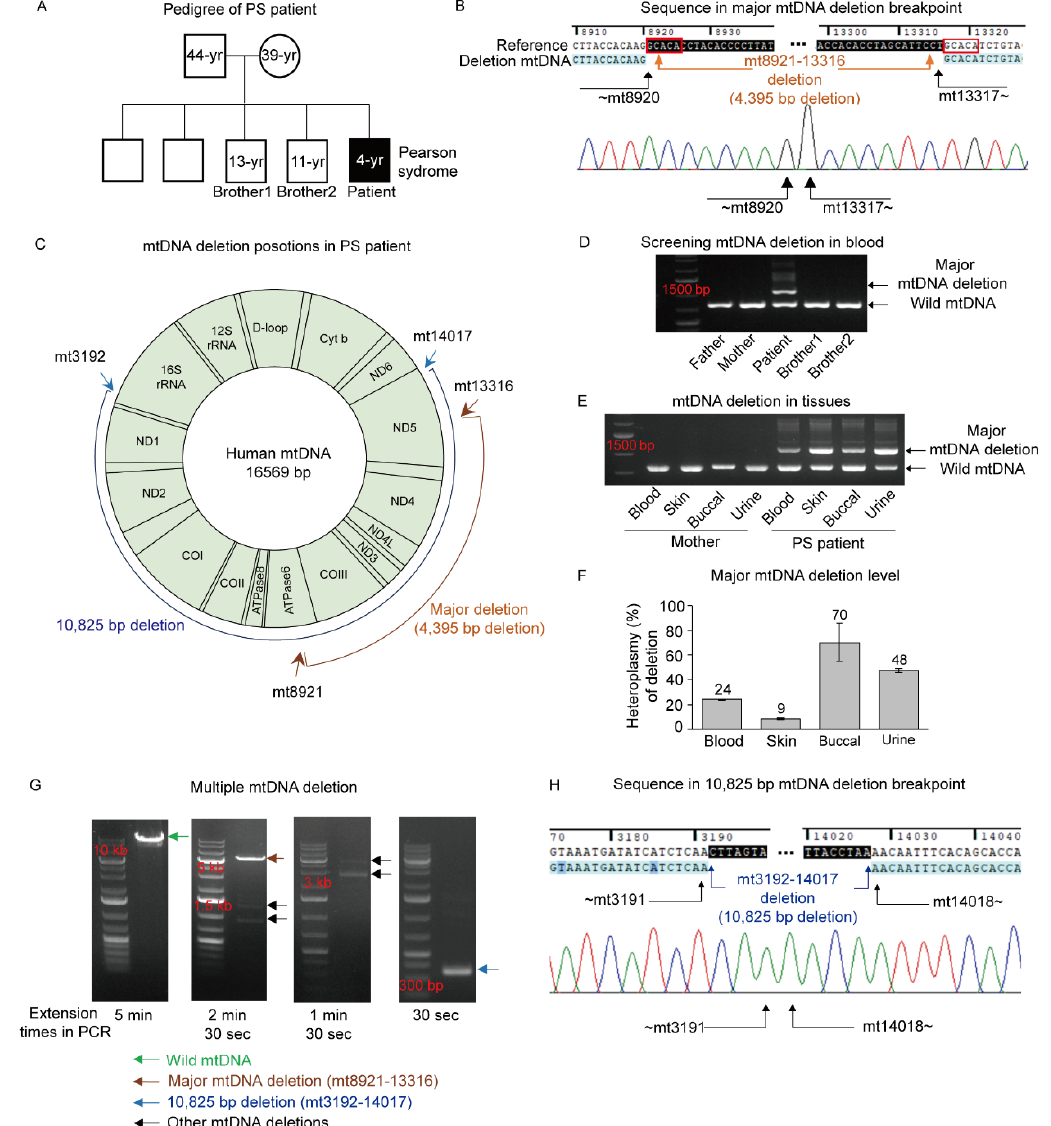
Figure 1. Mitochondrial DNA (mtDNA) deletions in a Pearson syndrome (PS) patient. ( A ) Pedigree of the PS patient: A male patient, diagnosed with Pearson syndrome, with healthy parents and four healthy brothers. ( B ) The breakpoint sequence around the 4395 bp deletion demonstrates that the deletion is flanked by 5 bp (GCACA) direct repeats (mt8921–8925 and mt13317–13321, red boxes). The automatic sequencing peak showing the breakpoints of the 4395 bp deletion spanning nucleotides 8921 and 13316 of the mtDNA. ( C ) Schematic of mtDNA deletions in the PS patient; major deletion, mt8921–13316; 10,825 bp deletion, mt3192–14017. ( D ) Screening for mtDNA deletion in blood samples from the PS patient and his family using PCR. PCR gel images showed that mtDNA deletion was detected only in the PS patient. Wild mtDNA represents the amplification of non-deleted mtDNA. ( E ) Detection of mtDNA deletion in various tissues from the PS patient and his mother using PCR. PCR gel images showed that the mtDNA deletion was detected only in the PS patient. Wild mtDNA represents the amplification of non-deleted mtDNA. ( F ) Heteroplasmy levels for the major mtDNA deletion (mt8921–mt13316) in multiple tissues from the PS patient. Each assay was completed in triplicate, and data are represented as the mean ± SEM. ( G ) Detection of mtDNA deletions. Multiple mtDNA deletions between mt3163 and mt14342 were detected at different PCR extension times. ( H ) The breakpoint sequence around the 10,825 bp deletion. Automatic sequencing peak showing the breakpoints of the 10,825 bp deletion spanning nucleotides 3192 and 14017 of the mtDNA.